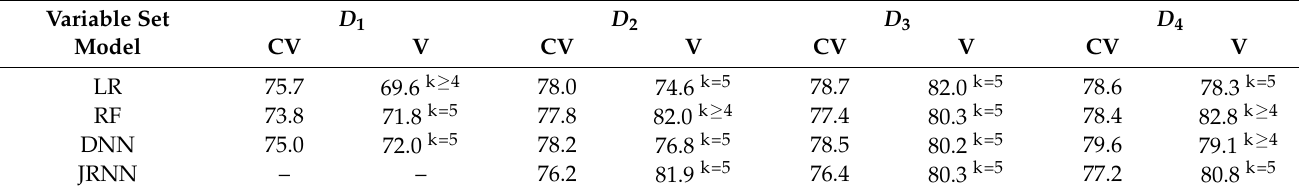
Table 4. Overall accuracy (%) of cross-validation (CV) and verification (V) across model types and variable sets. The k -fold consensus threshold that yields the best verification accuracy is denoted in superscripts. Variable Set